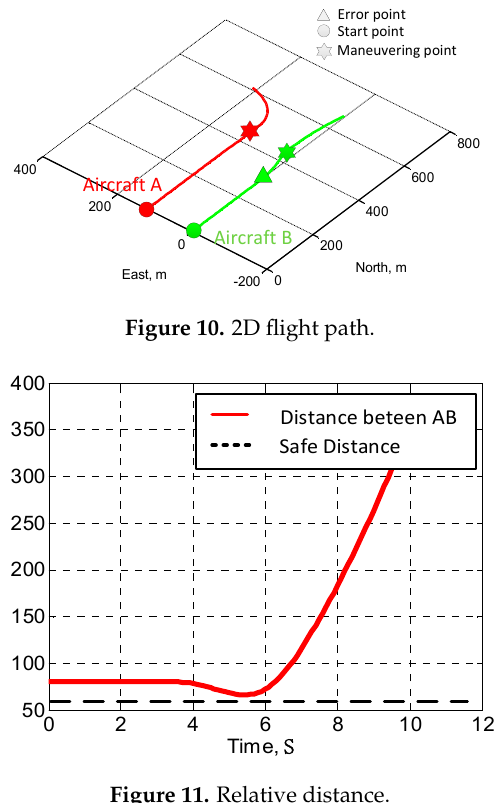
Figure 11. Relative distance.